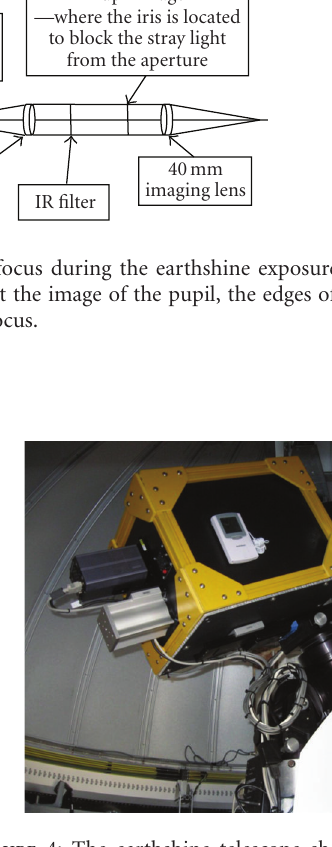
Figure 4: The earthshine telescope shown inside its dome. The light-shielding yellow box extends about one-half meter along the optical